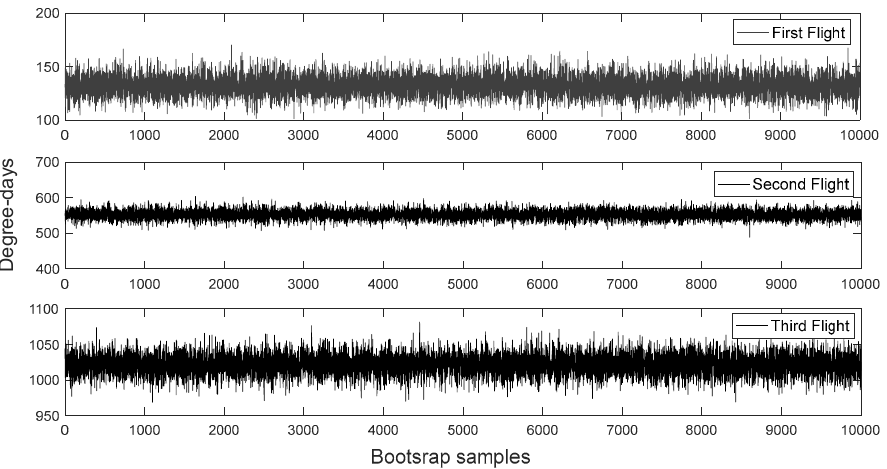
Figure 4. Simulation of a sample of n = 10,000 bootstrapped means, 𝜃(cid:3552) (cid:4666)(cid:2869)(cid:4667)∗ ,…,𝜃(cid:3552) (cid:4666)(cid:2869)(cid:2868)(cid:2868)(cid:2868)(cid:2868)(cid:4667)∗ , of random sam ‐ ples taken with replication from the vector of moth phenology for the first, second and third flight of H. armigera .